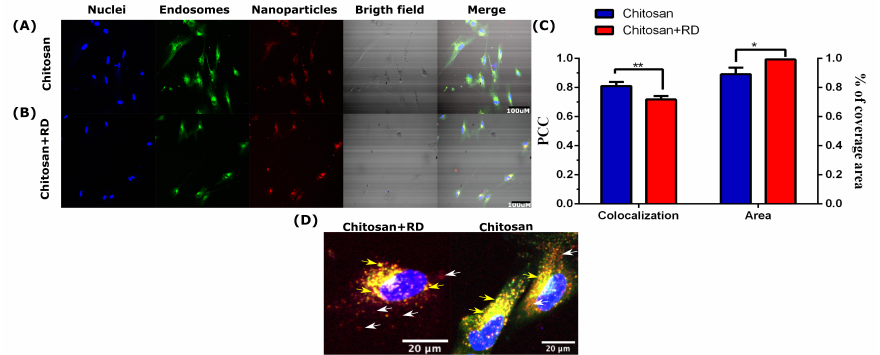
Figure 8. Cell-Penetration assay. ( A ) Internalization of bare CNPs into NHA cells ( B ) and CNPs- RD10 nanobioconjugates (20X magnification, 3 h of exposure). The scale bar corresponds to 100 µ M. ( C ) Quantification of colocalization between CNPs and CNPs-RD10 nanobioconjugates by the Pearson correlation coefficient (PCC) and the fraction of cytosol area covered by CNPs and CNPs- RD10 nanobioconjugates. There is a statistically significant difference between both treatments. p ≤ 0.05 (*), p ≤ 0.01 (**). ( D ) Visual inspection of colocalization studies via confocal imaging. Yellow arrows point to colocalization regions between the green and the red channels, showing CNPs or CNPs-RD10 nanobioconjugates trapped in endosomes. The white arrows indicate non-colocalized regions where CNPs or CNPs-RD10 nanobioconjugates likely escaped endosomes or reached the intracellular space by different internalization